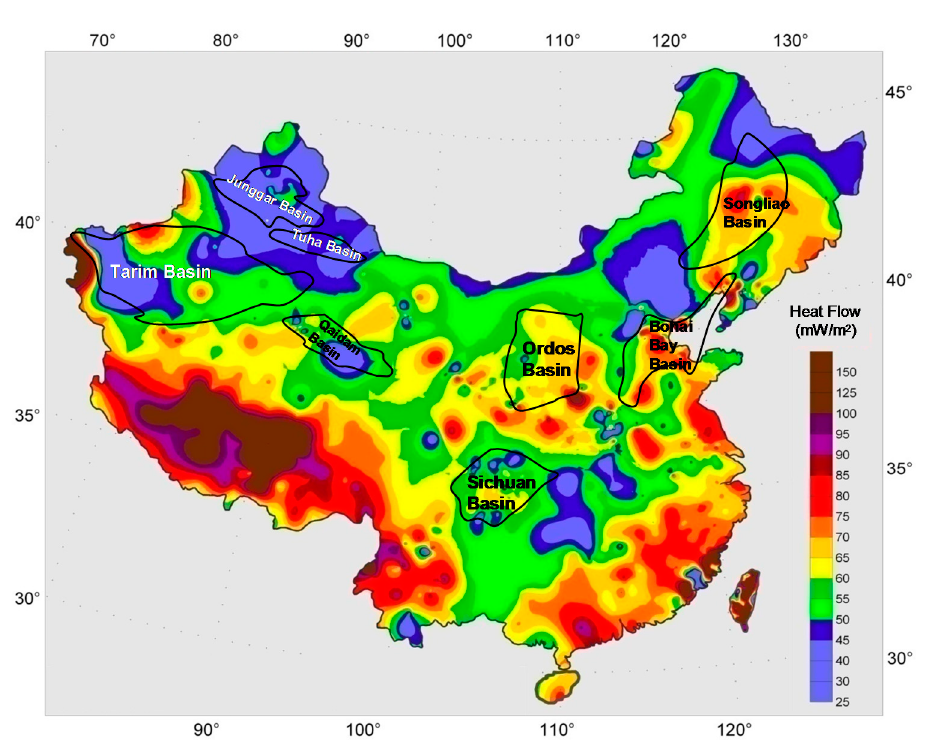
Figure 1. Distribution of petroliferous basins and heat flow in China [9].